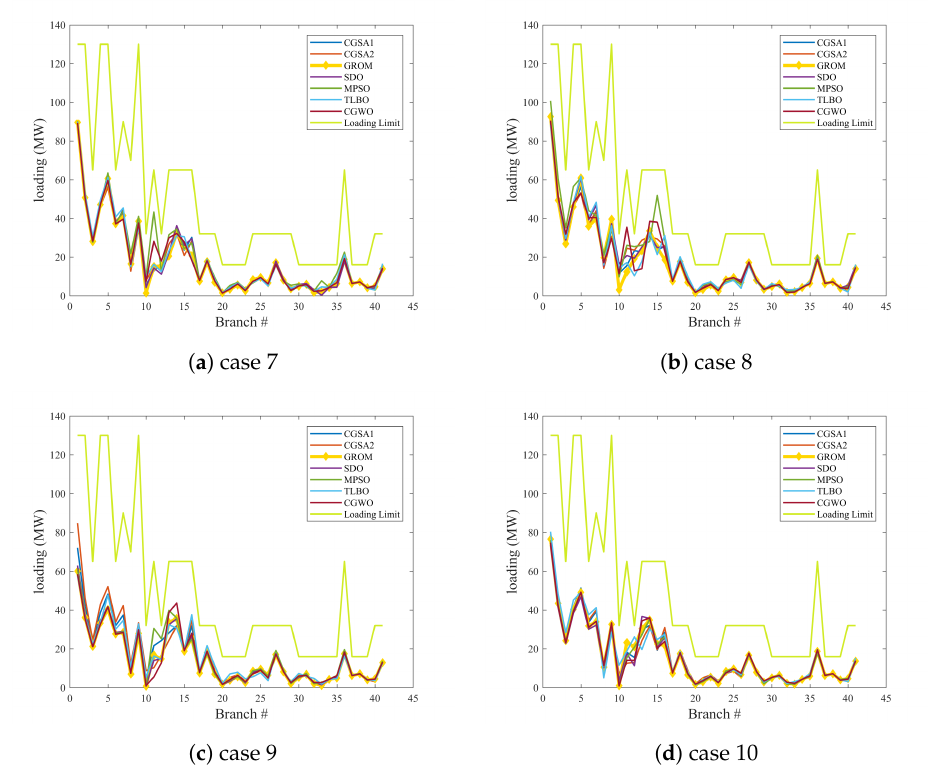
Figure A5. Loading Profile for multi-objective optimal power